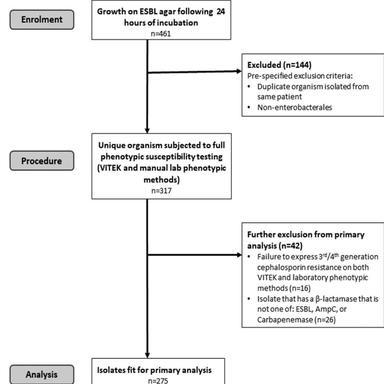
low diagram of method.